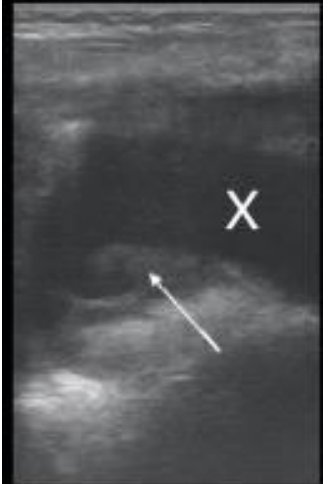
Figure 3. Pleural effusion with transonic liquid (marked with X) and hyperechoic plankton sign of exudative pleurisy (white arrow).